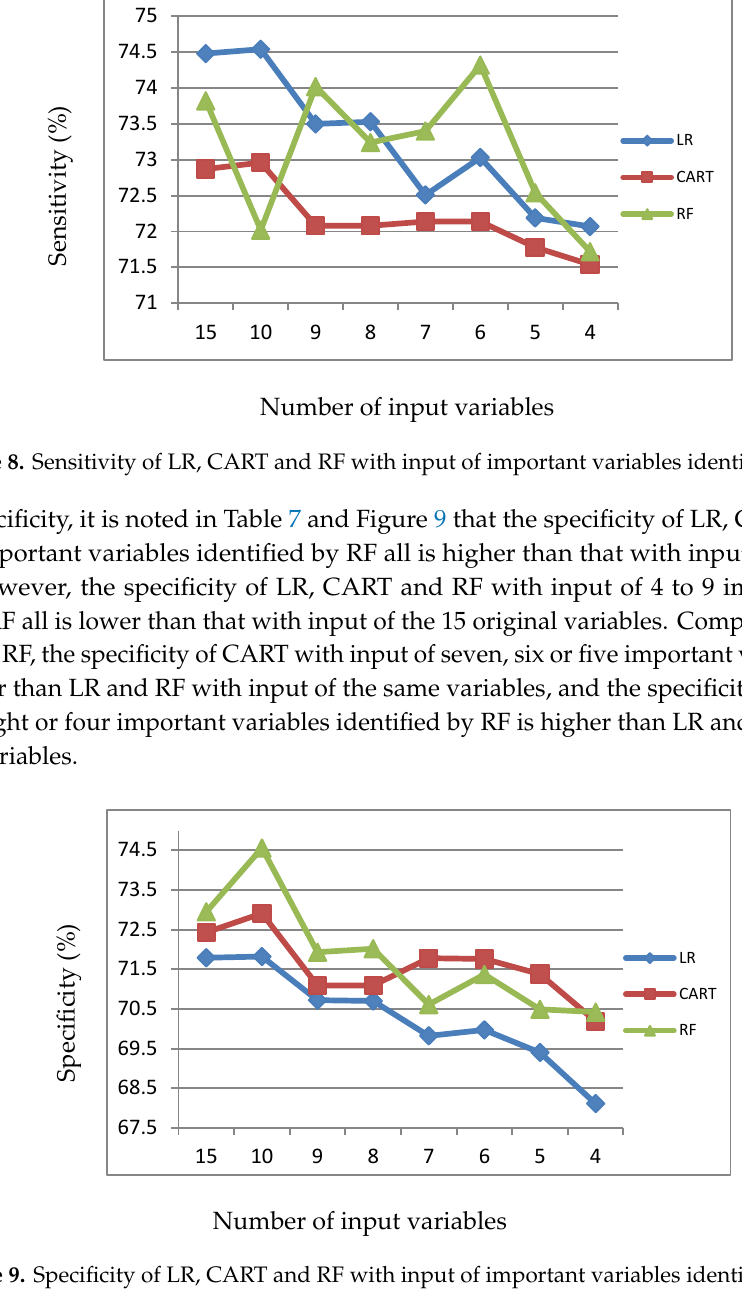
Figure 9. Specificity of LR, CART and RF with input of important variables identified by RF.